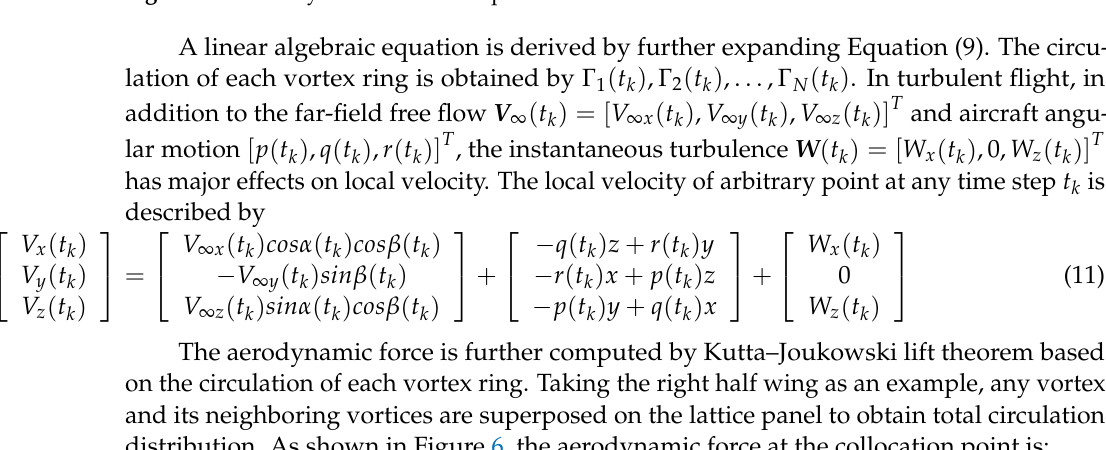
Figure 5. Boundary condition decomposition in